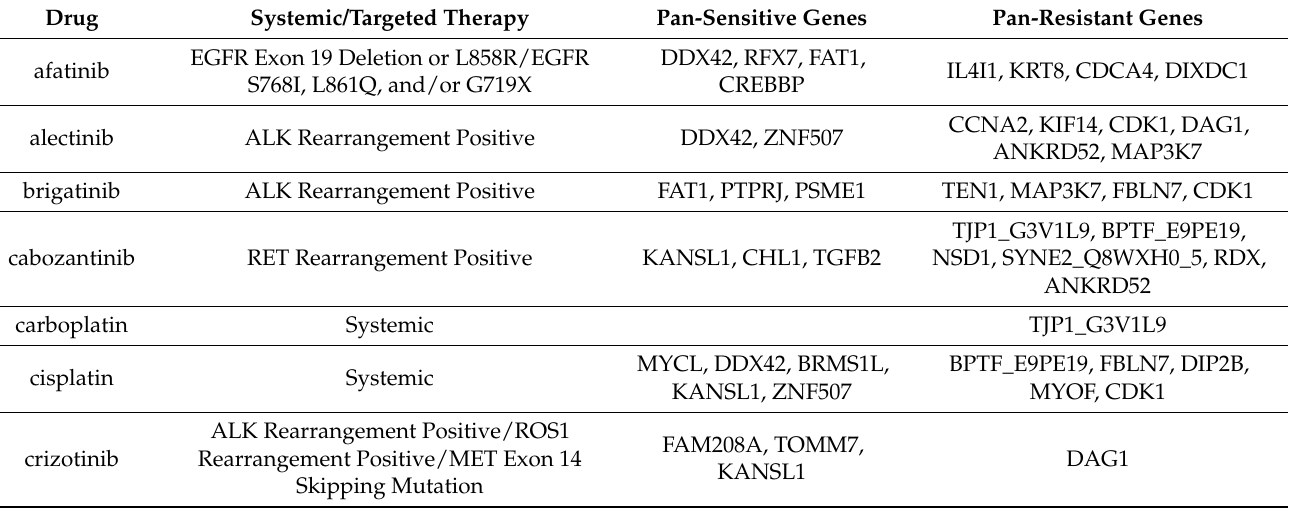
Table 2. Pan-sensitive and pan-resistant genes to 21 drugs using proteomics data in CCLE NSCLC cell lines ( n =